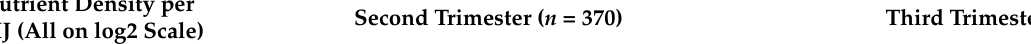
Table 3. Variables with significant relationships between log2 (nutrient density per MJ